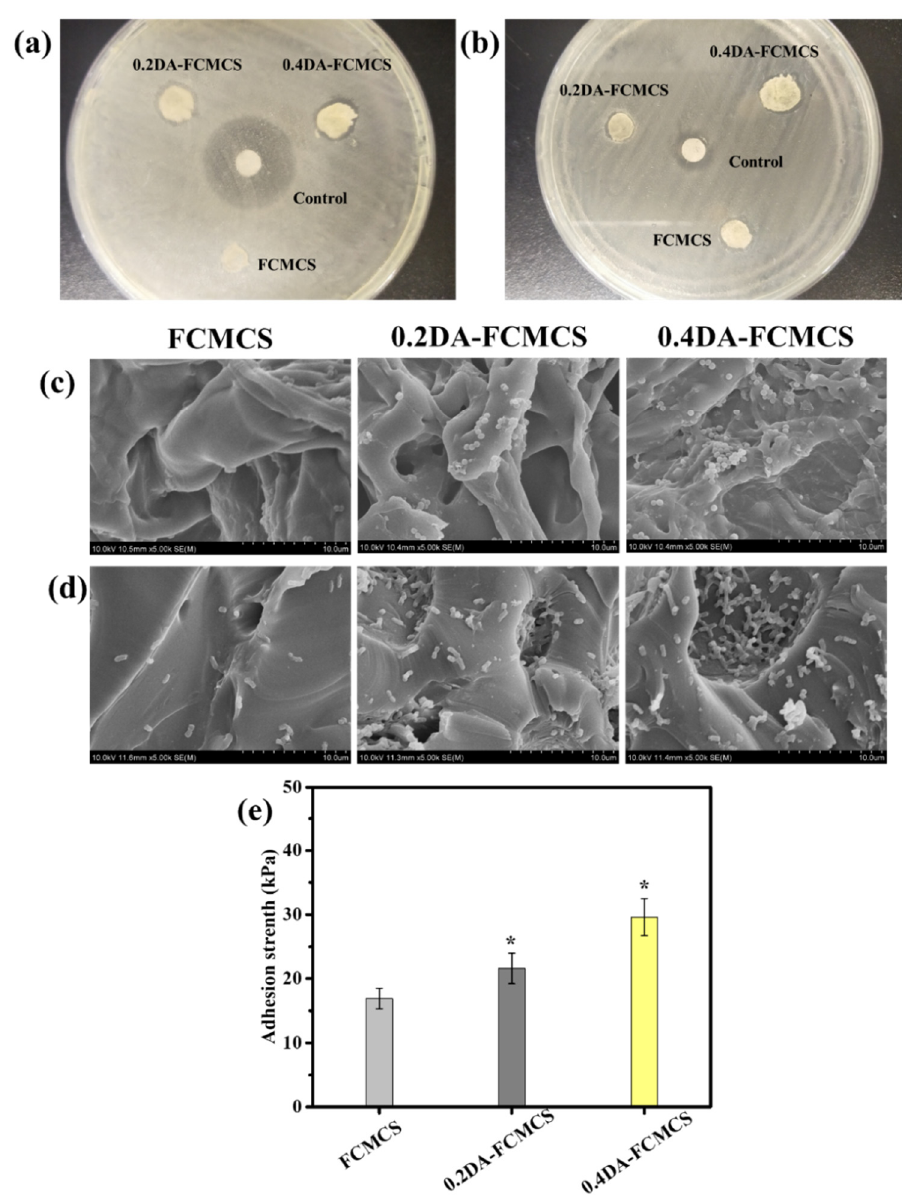
Figure 12. Antibacterial activity of hydrogels against ( a ) E. coli and ( b ) S. aureus using disc diffusion method, SEM images of bacterial adhesive property of hydrogels against ( c ) E. coli and ( d ) S.aureus and ( e ) adhesion strength of hydrogels to porcine skin (N = 3, * p < 0.05).